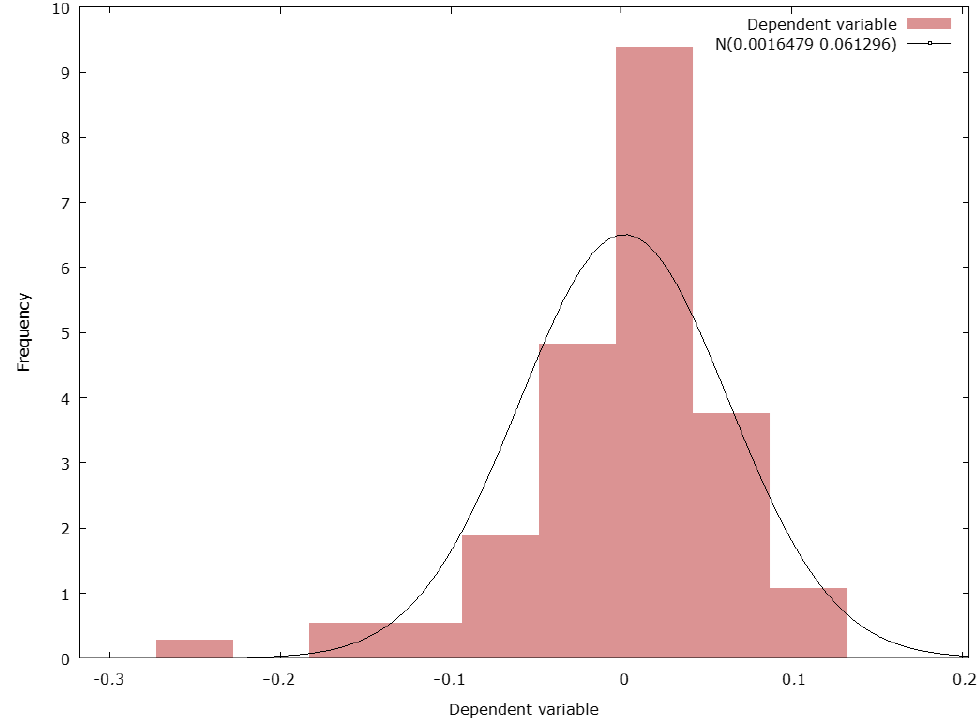
Figure 4. Histogram of the normal distribution of the dependent variable of the American model.